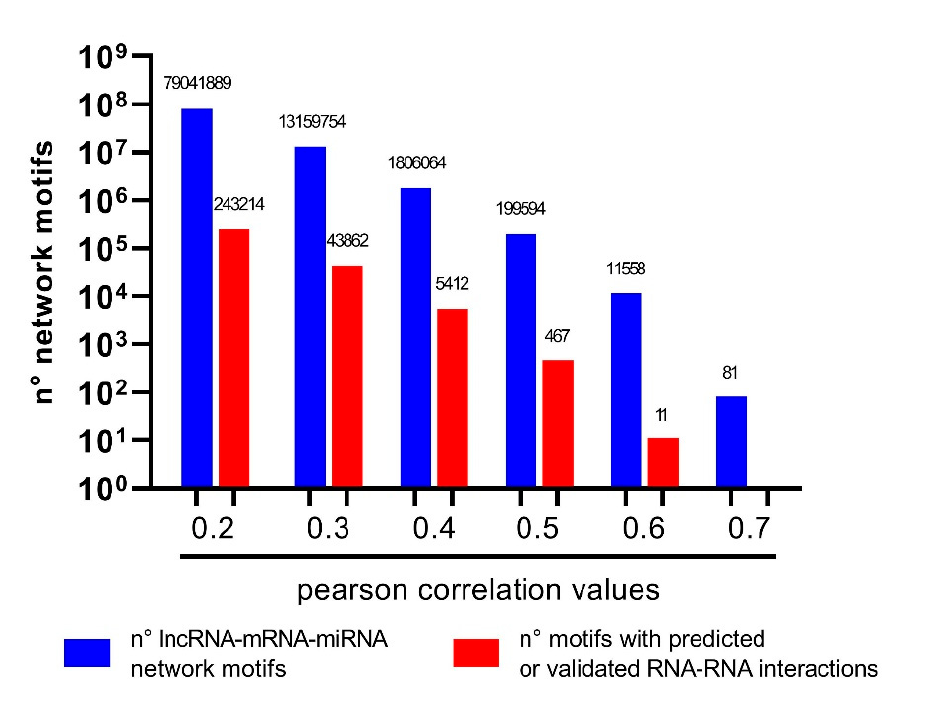
Figure 7. Generation of lncRNA–miRNA–mRNA axes stored in VECTOR. LncRNA–miRNA–mRNA axes (triangle-shaped network motifs) were computed by using different correlation coefficient thresholds (blue bars) and matched with the same network motifs also featuring the predicted or validated interactions in the miRNA–lncRNA and miRNA–mRNA axes (red bars). Table 1. LncRNA–miRNA–mRNA axes featuring physical interactions calculated by using the most stringent threshold (correlation coefficient > 0.6).